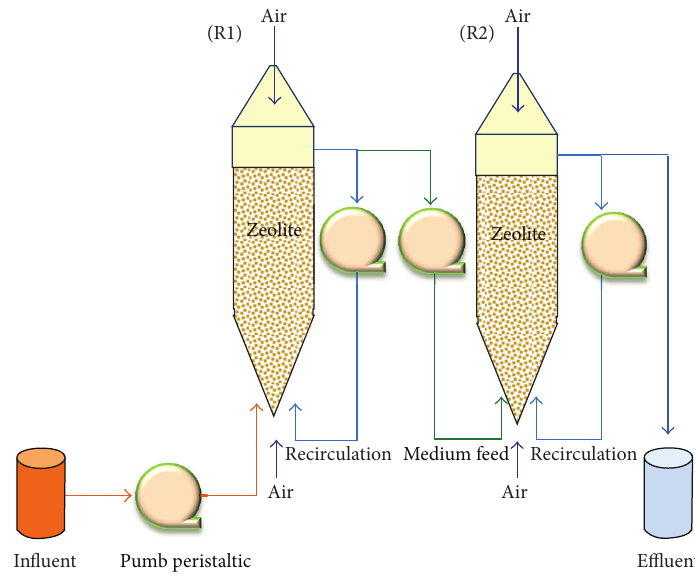
Figure 1: Schematic diagram of the upstream flow of the aerobic reactors packed with